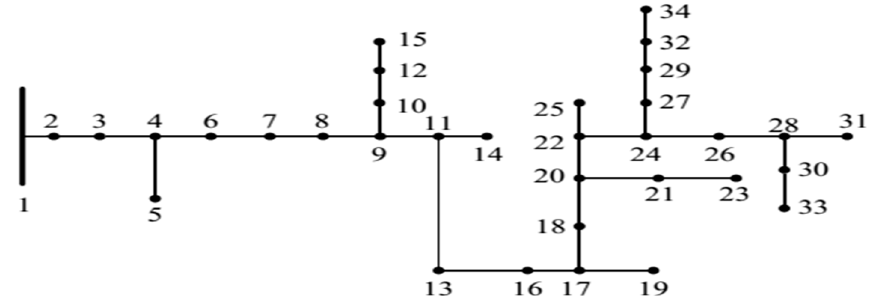
Figure 2. Distribution System of 34 bars.